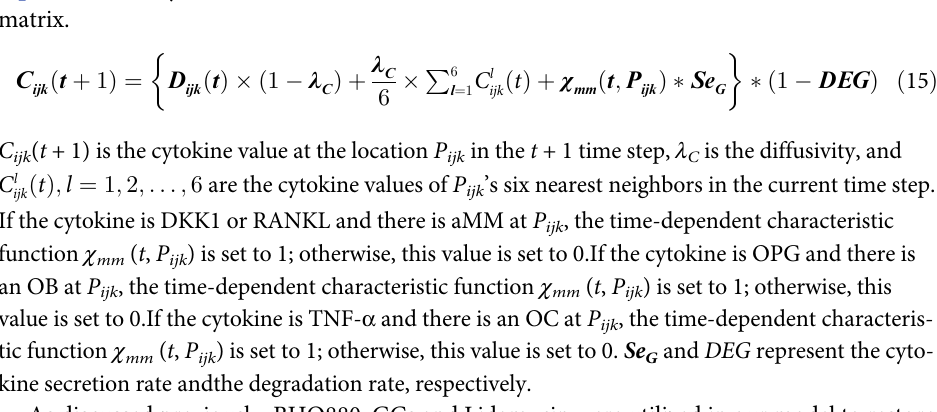
Tissue Scale: cytokine and drug